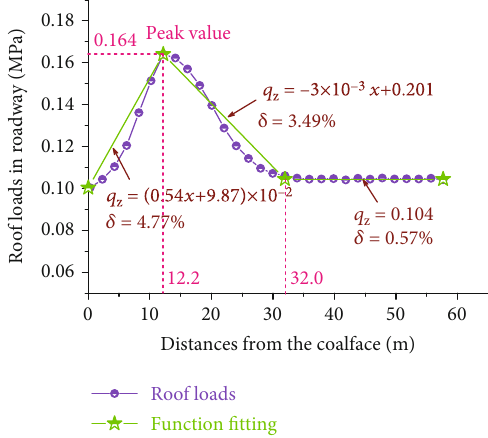
Figure 9: Distribution of the roof loads in